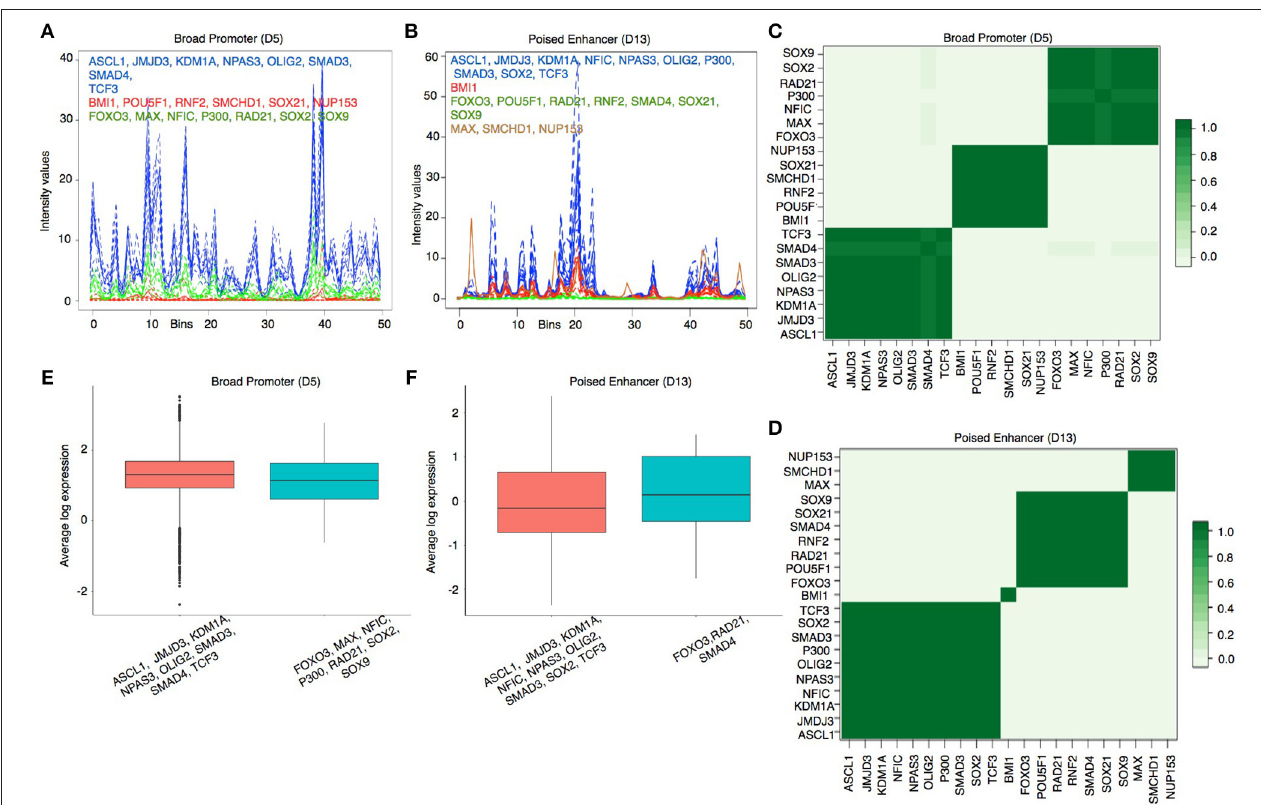
FIGURE 4 | (A,B) Estimated cluster binding intensities along with the individual TF binding intensities in the Broad Promoter and Poised Enhancer states, respectively. In each figure, the estimated binding intensities of the individual TFs are shown in dotted lines and the estimated binding intensities of the clusters are shown in solid line. TFs in each cluster are shown in the same color as that of the cluster. The X axis represents the genomic locations mapped on the real line between 0 and 50. The Y axis represents the estimated binding intensities, both for the individual TFs and for the identified clusters. (C,D) Pairwise protein co-binding probabilities corresponding to (A,B) respectively. (E,F) Comparison of proximal gene expressions (TPM) regulated by the clusters in (a) and (B) respectively. Only those clusters having (1) multiple TFs and (2) proximal genes for at least two TFs are shown in the figure to explain the combinatorial regulation of gene expressions by multiple